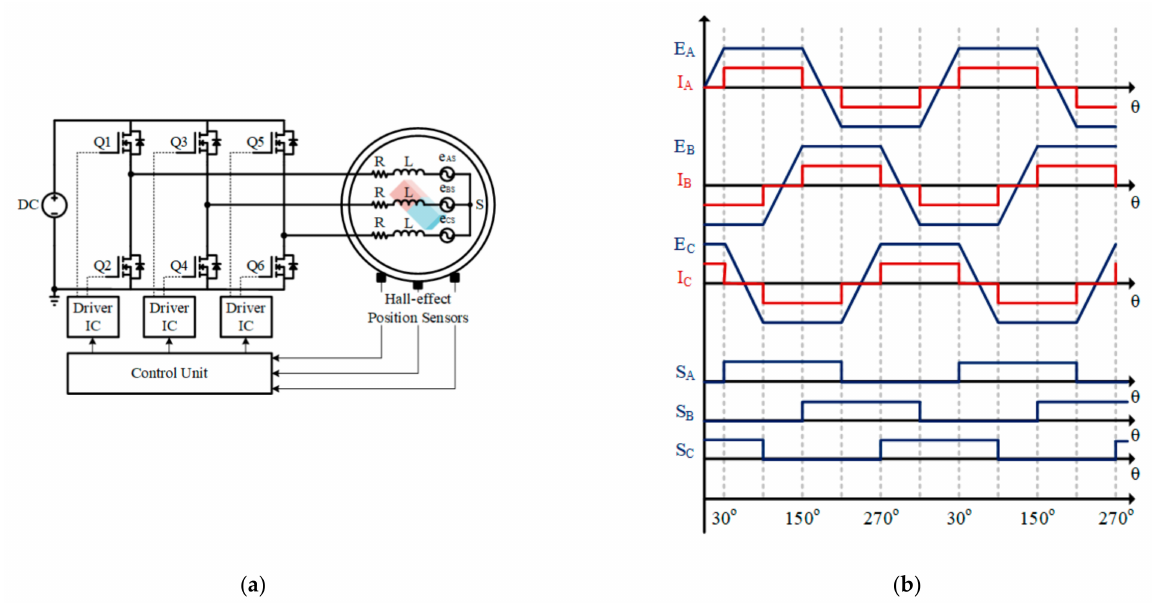
Figure 1. ( a ) Block diagram of a typical brushless DC motor drive with built-in Hall-effect position sensors, ( b ) Ideal waveforms of the Back-EMFs (E x ) and the phase currents (I x ) according to the Hall-effect position sensor signals (S x ) and the rotor position, where x = A, B, and C.